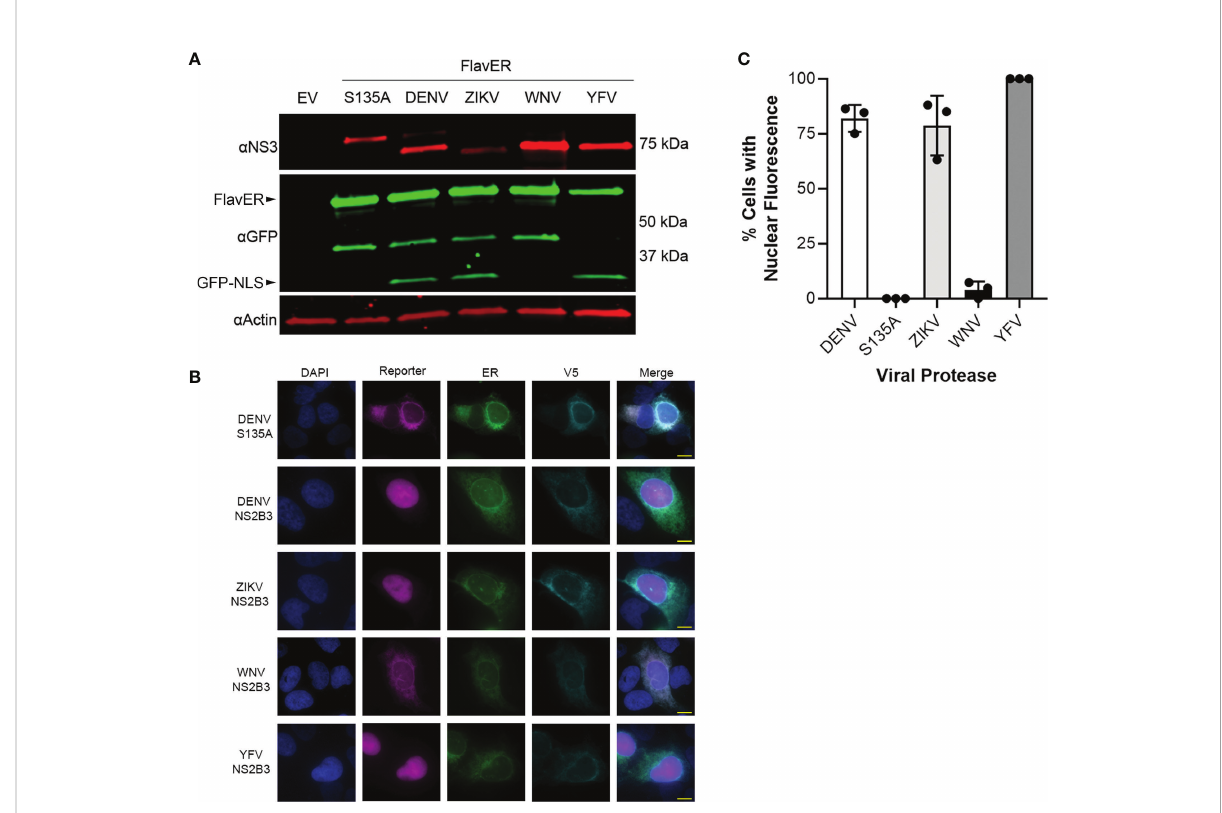
FIGURE 5 FlavER is cleaved by multiple fl avivirus proteases. (A) Immunoblot for NS3, GFP, and actin for U2OS cells co-transfected with FlavER and the indicated fl avivirus protease. (B) Immuno fl uorescence microscopy images of U2OS cells co-transfected with FlavER and the indicated V5- tagged protease. Reporter is shown in magenta, ER marker is shown in green, V5 staining is shown in cyan, and nuclei are stained with DAPI (blue). Scale bars represent 20 m m. (C) Quanti fi cation of IF images of cells expressing FlavER and the indicated V5-tagged viral protease. Data is presented as ef fi ciency of cleavage determined by the percentage of co-expressing cells with nuclear-translocated fl uorescent infection reporter, n=3. Data points represent results from three different fi elds of view, with the averages shown as bar graphs.